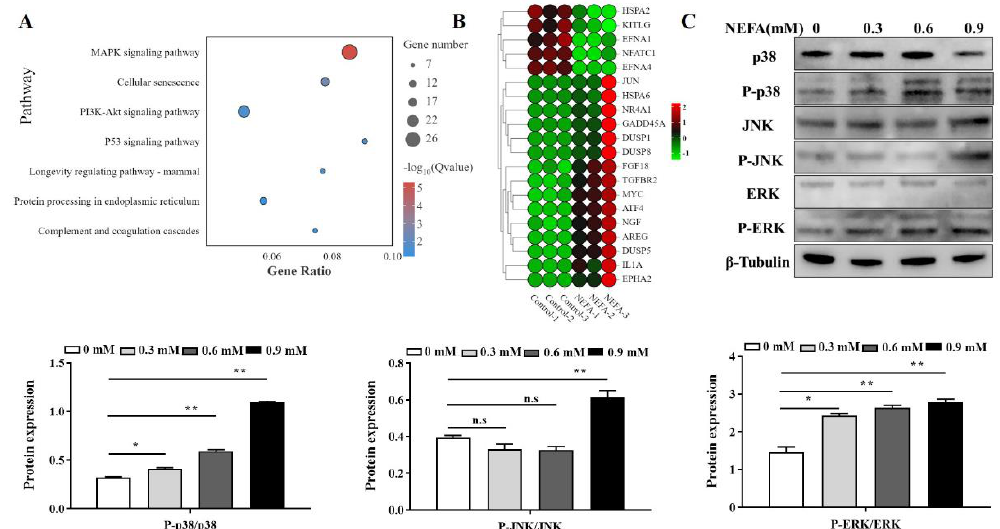
Figure 6. The MAPK signaling pathway was involved in NEFA − induced apoptosis. ( A ) The KEGG pathway enrichment analysis of the different NEFA treatment − activated genes. ( B ) Thermogram analysis of expressions of MAPK pathway − related genes. ( C ) The protein expression of MAPK pathway − related genes in BMECs stimulated with NEFA for 6 h. Data are presented as the means ± the standard errors of the mean (SEM) of three independent experiments. * p < 0.05; ** p < 0.01.